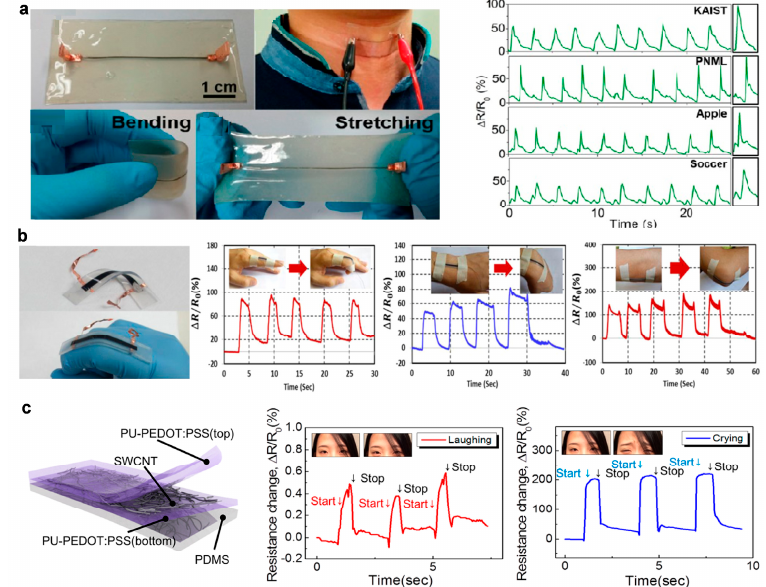
Figure 6. Examples of skin sensors for strain sensing: ( a ) graphene strain sensor embedded in an elastomeric patch that is bendable and stretchable, for detection of the motions of throat (Reprinted with permission from Ref. [17] Copyright 2015 American Chemical Society); ( b ) application